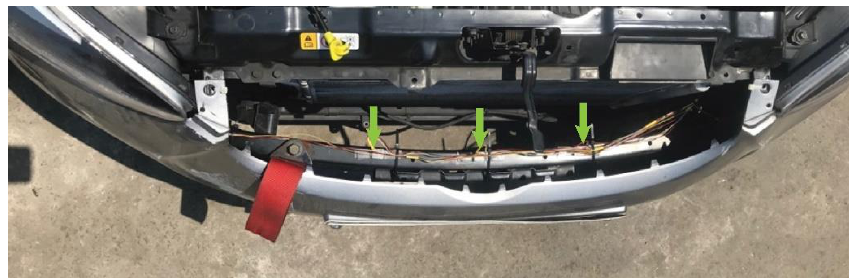
Figure 15. Numerical model for collision of vehicle.